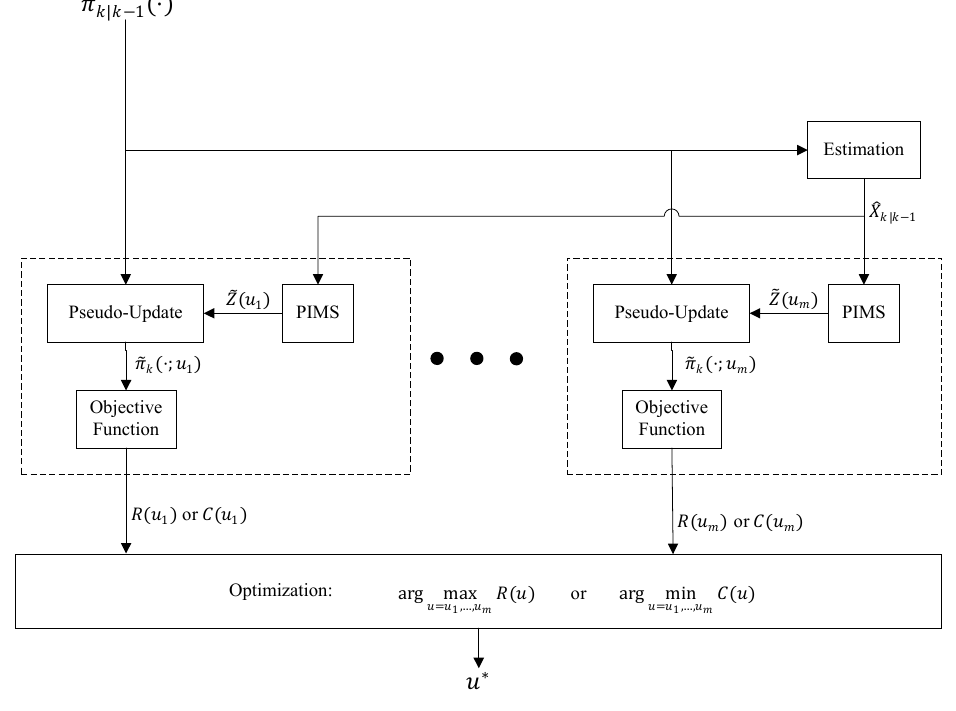
Figure 2. The most common approach to implement the “Sensor Control” block in Figure